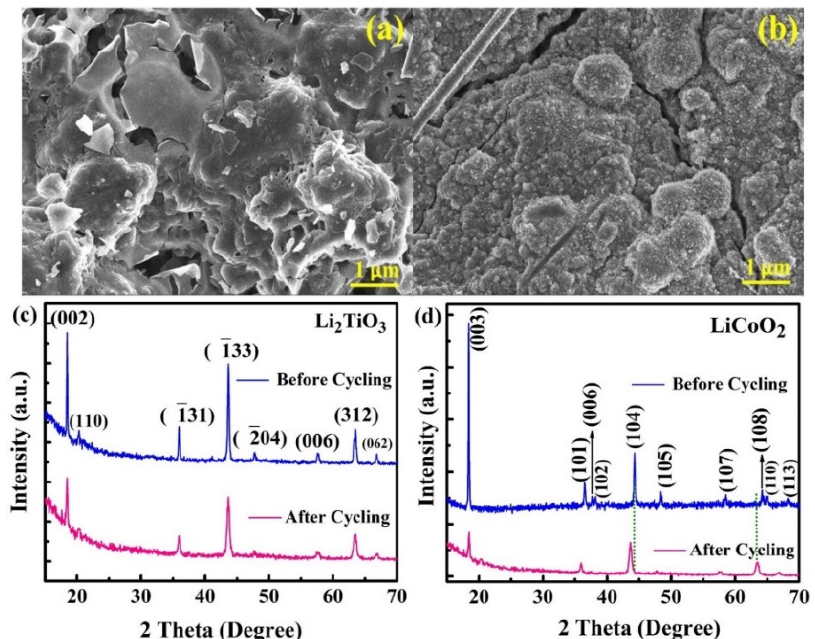
Figure 8. Post-mortem analyses of LTO and LCO electrodes. FE-SEM images after 50 cycles of ( a ) Li 2 TiO 3 and ( b ) LiCoO 2 . X-ray diffraction patterns before and after cycling of ( c ) Li 2 TiO 3 and ( d ) LiCoO 2 .